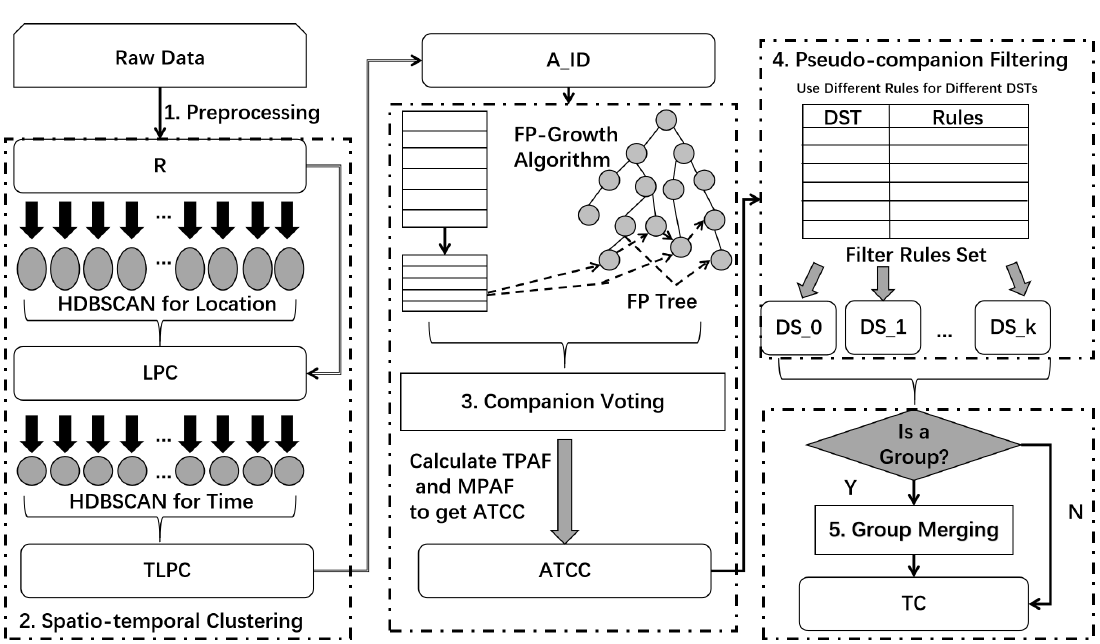
Figure 3. The Detailed Process Example of